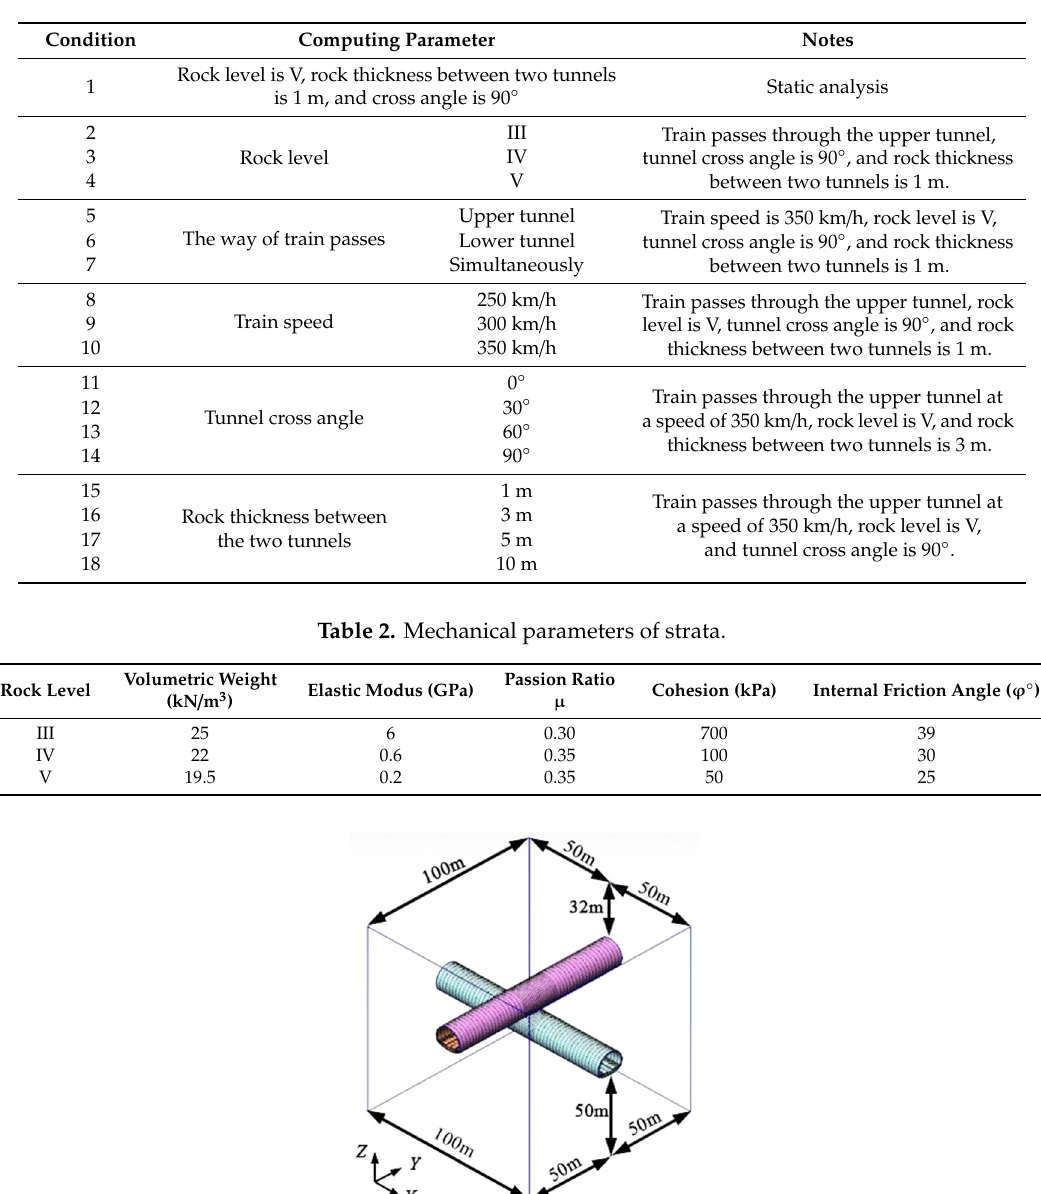
Table 1. Conditions for the numerical model.